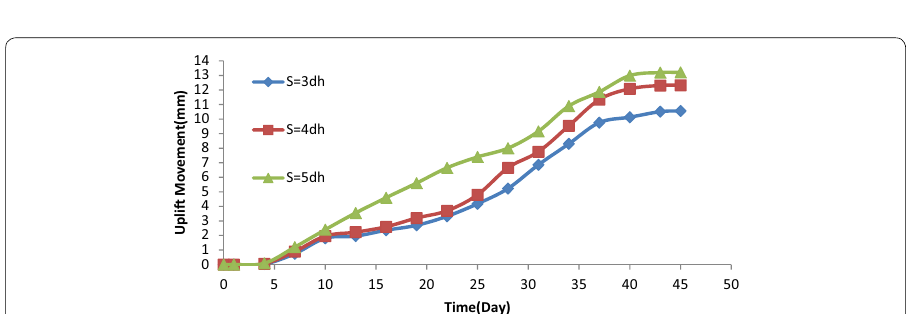
Fig. 33 Variation of uplift movement with time for pile group of L/D